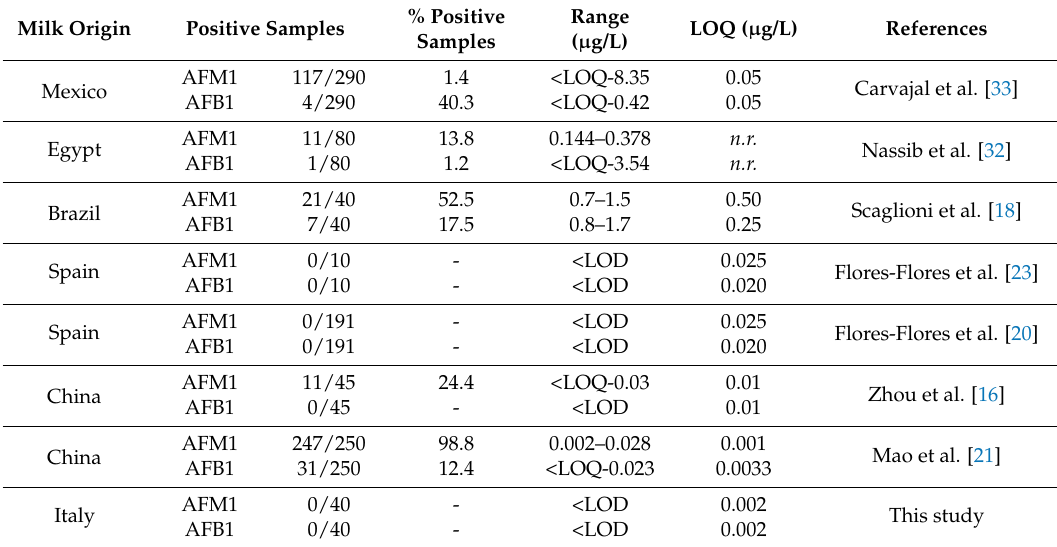
Table 3. Simultaneous occurrence of AFB1 and AFM1 in milk samples, reported in